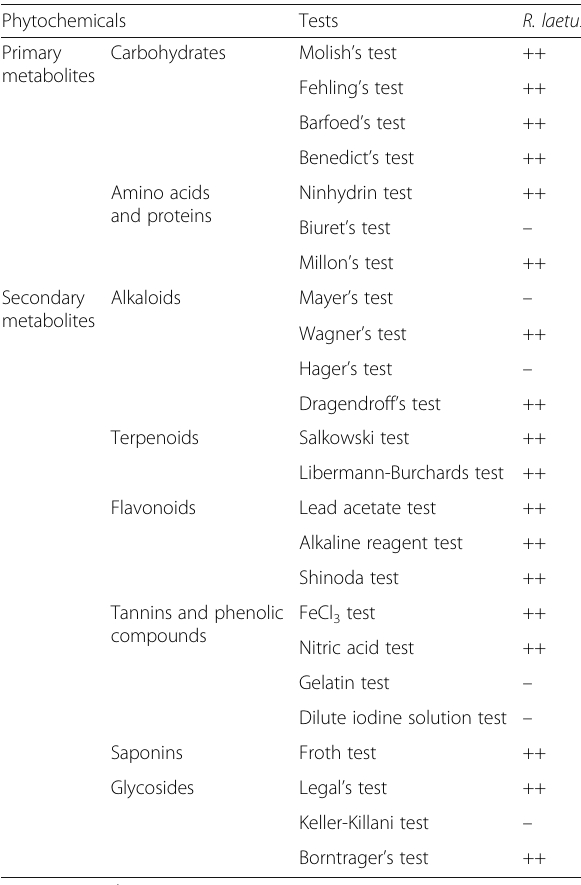
Table 1 Phytochemical investigation of ethanolic leaf extract of Ranunculus